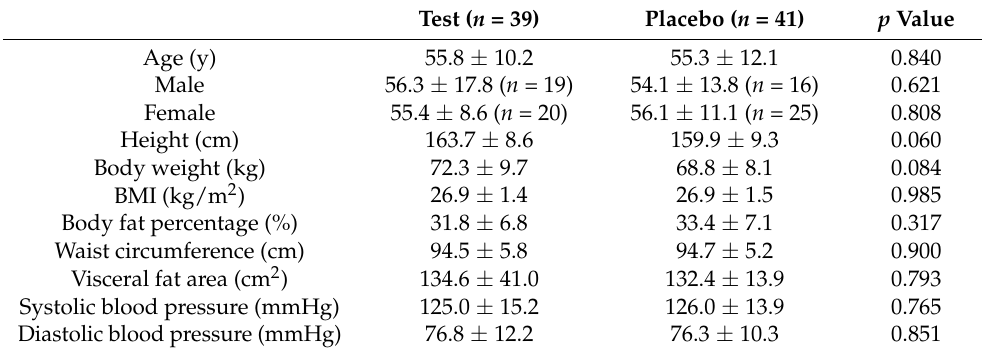
Table 1. The characteristics of the eligible participants at